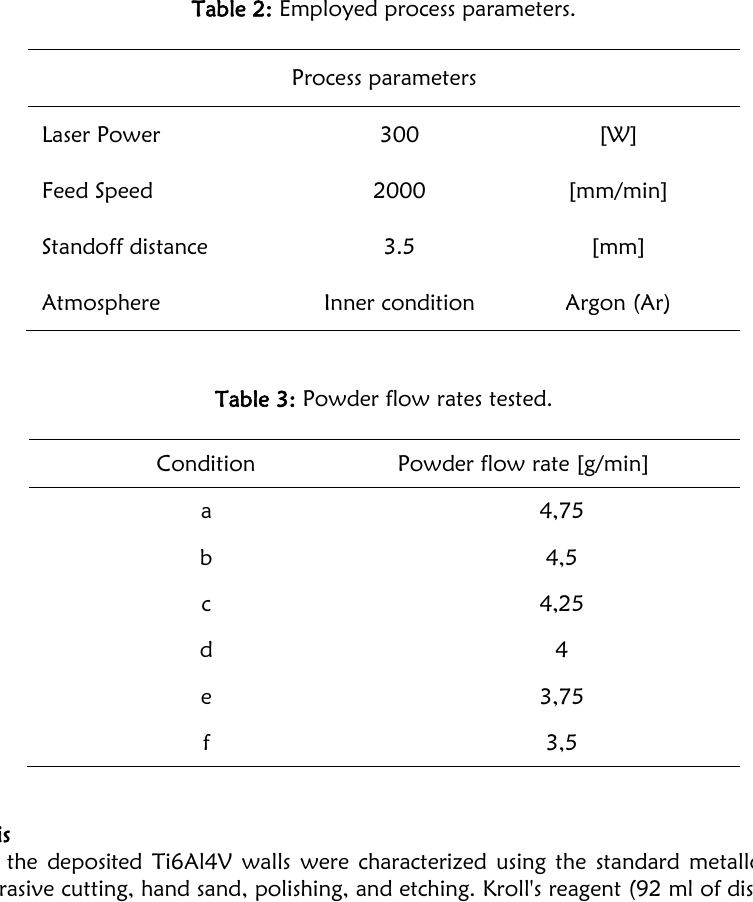
Table 2: Employed process parameters.